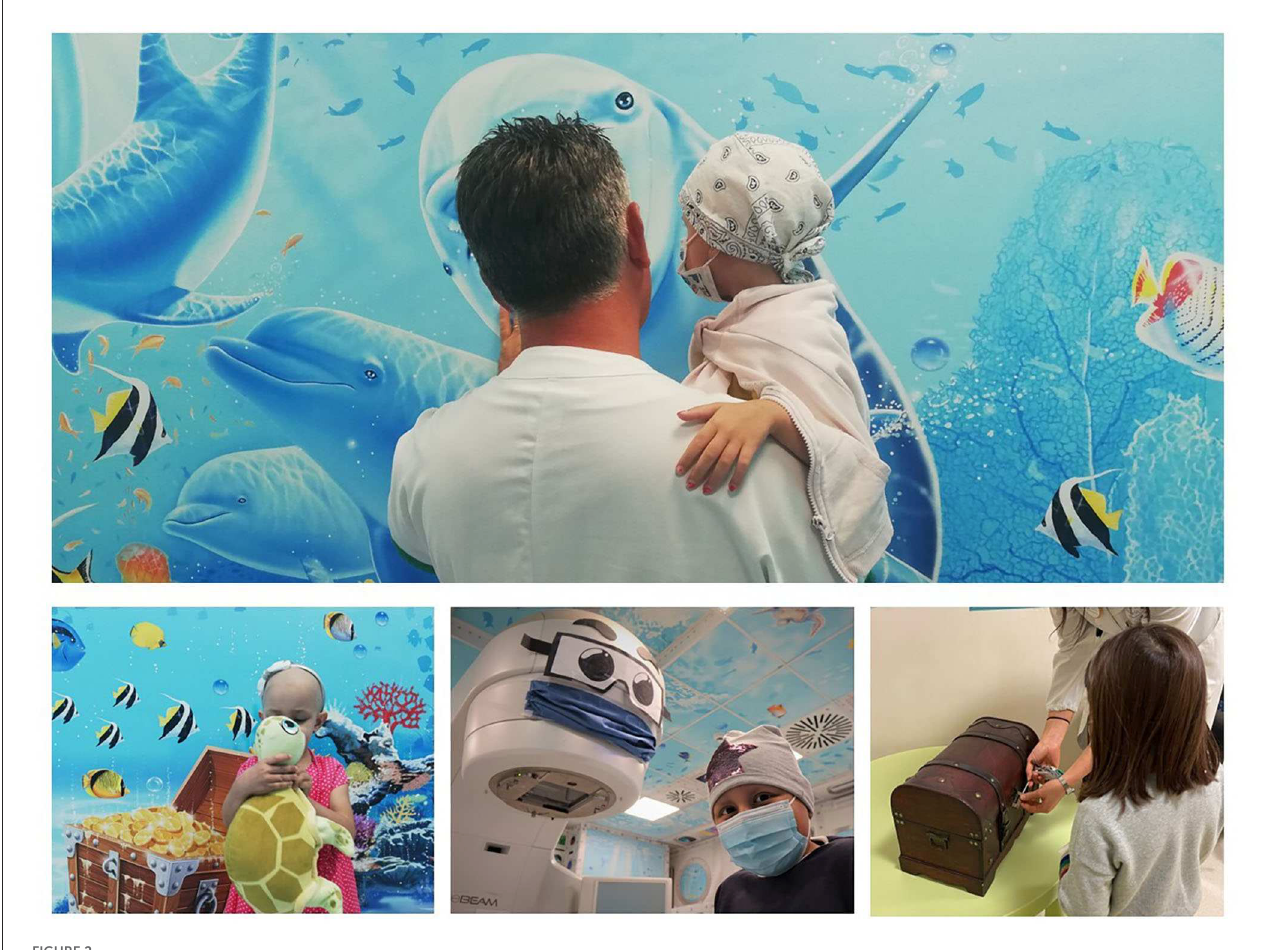
FIGURE2 Pediatric radiotherapy, any RADAR pathway’ images and